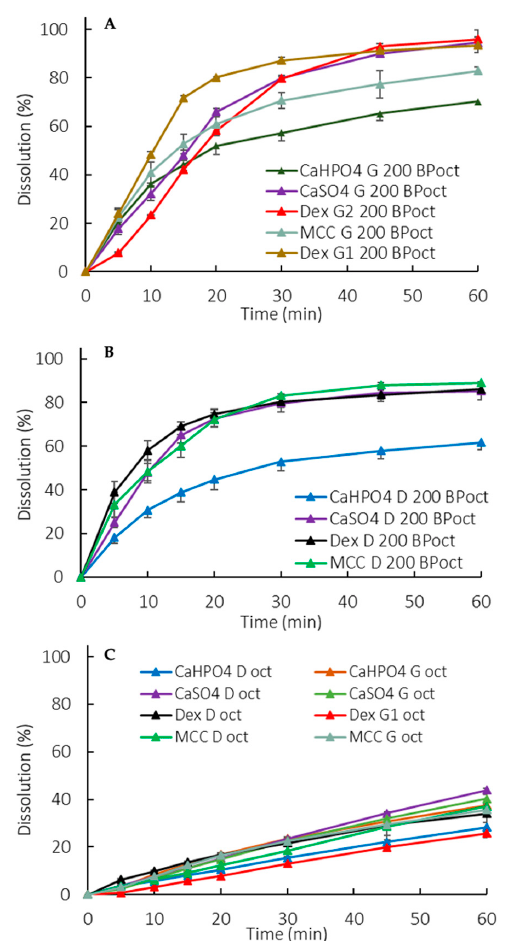
Figure 4. Organic phase partition profiles in a biphasic dissolution with 200 mL of aqueous media for G formulations ( A ) and D formulations ( B ) and with 900 mL of aqueous media ( C ). Oct: Octanol. Error bars represent the standard deviation.